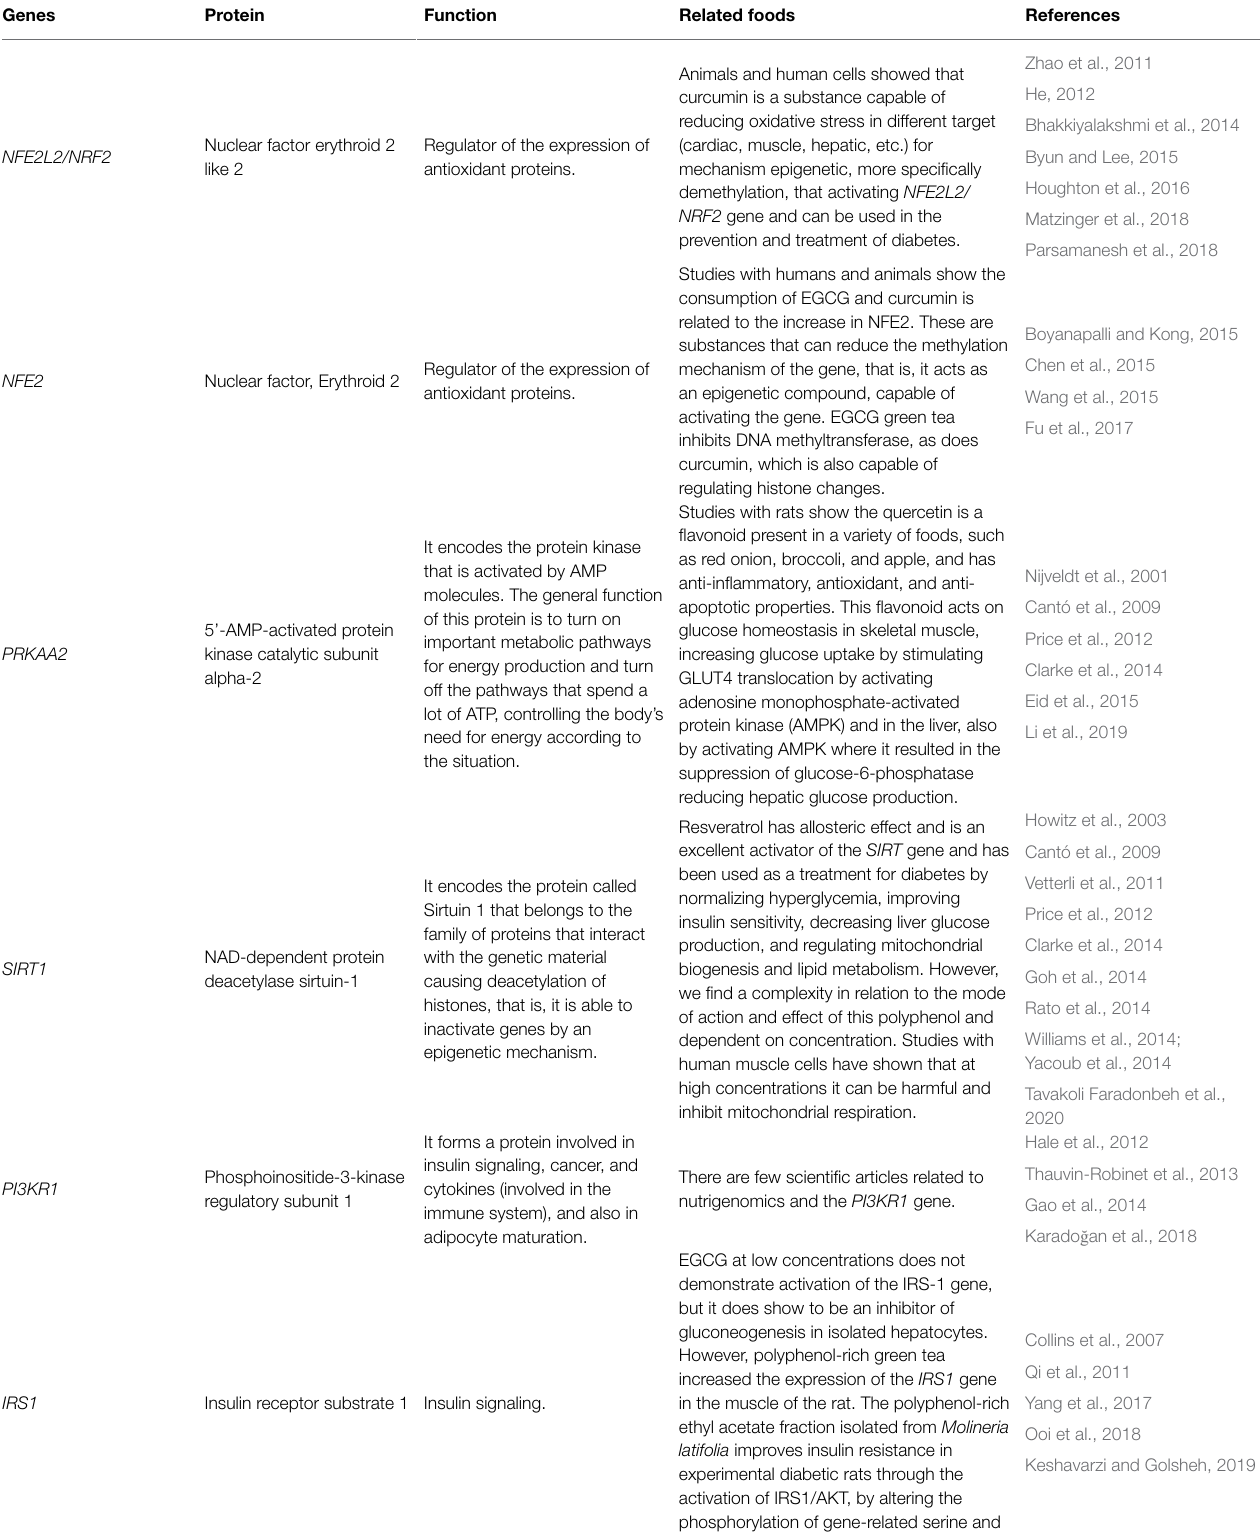
TABLE 1 | Genes associated with type 2 diabetes mellitus (T2DM) and respective bioactive compounds found in foods that are capable to change in expression. Genes Protein